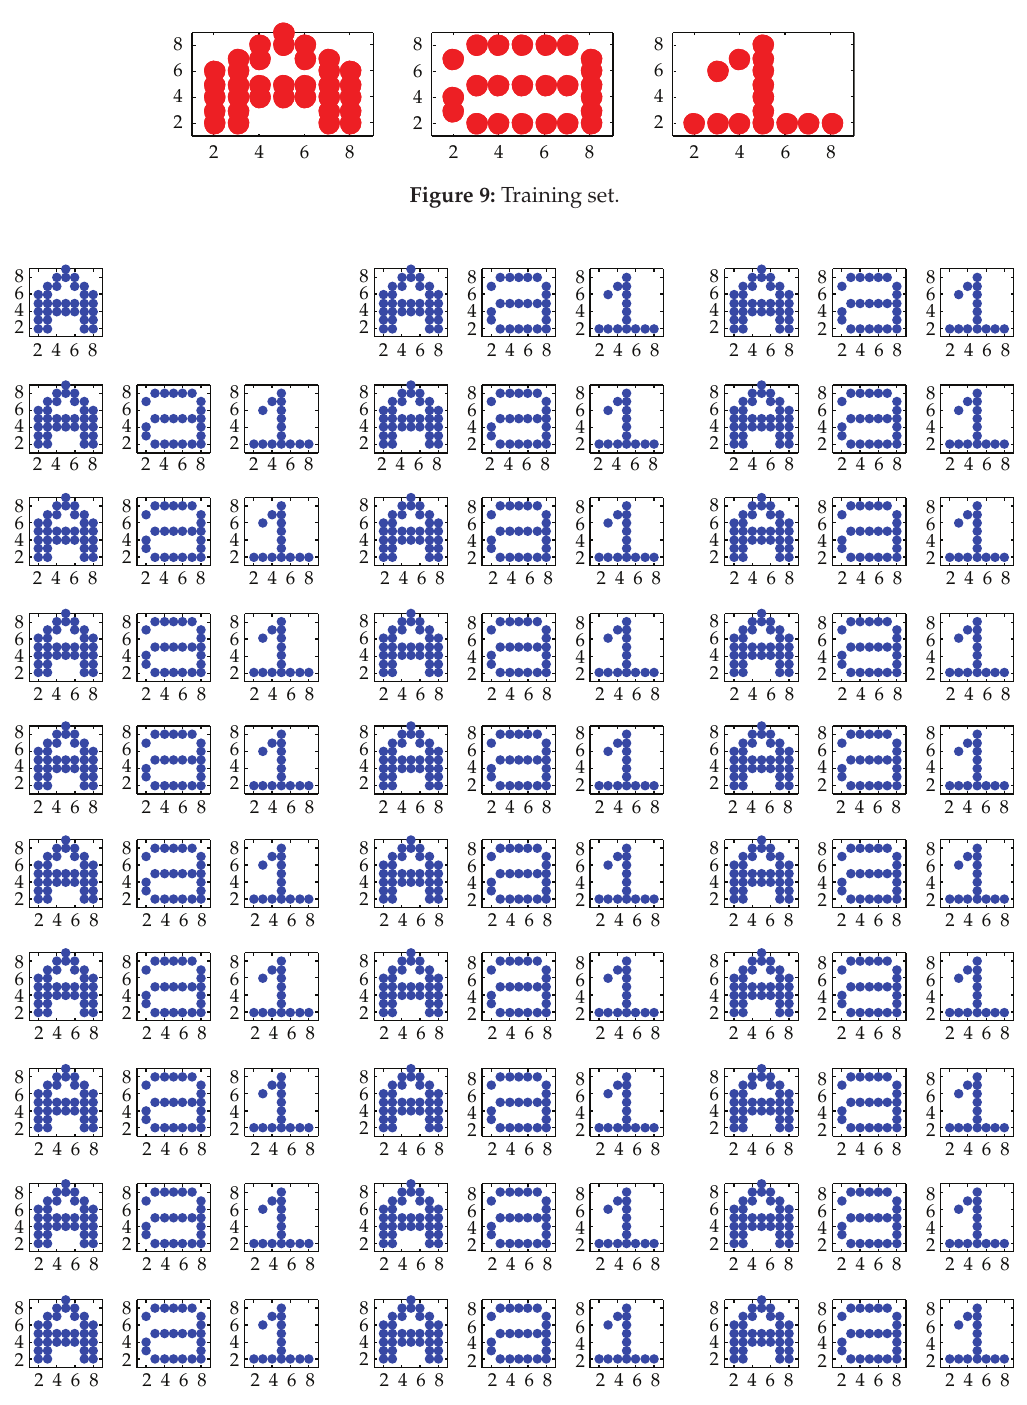
Figure 10: Output of a MCNN for one-to-many